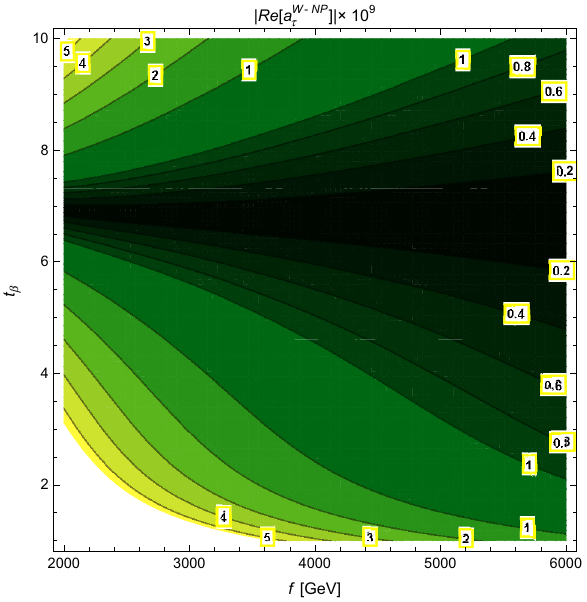
Fig. 9 Contours of the SLHM contribution to the absolute value of the real part of a W − NP τ in the f vs. t β plane. For the remaining parameters of the model we use the values shown in Table 2